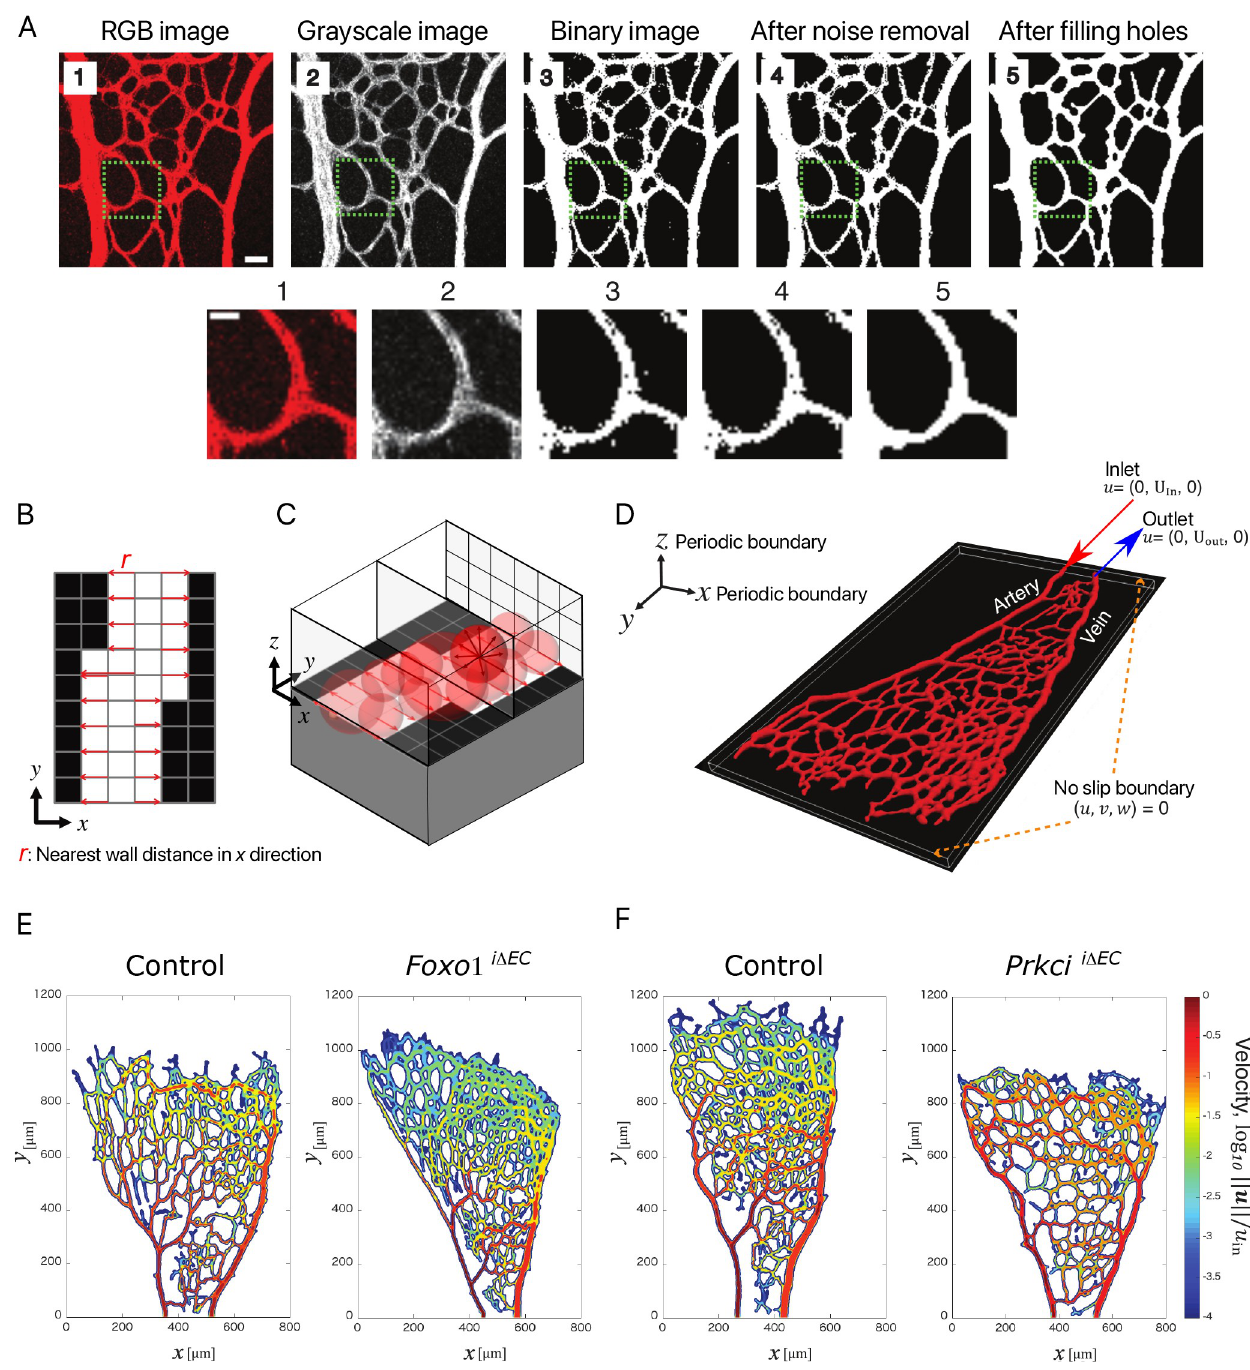
Fig 2. Image processing and blood flow simulation from the growing mouse retinal vasculature. A) Generation of binary vessel mask from RGB images. Higher magnification images of indicated areas in the upper panels are shown in the lower panels. Scale bar in the upper panel, 30 μ m; 10 μ m in the lower panel. B) Schematic of the searching process for the nearest solid wall (black pixel) on each pixel point and defining the local radius r (pixel distribution is projected on Cartesian grid coordinate ^ x = [ x , y ]). C) The local radius r for creating 3D vascular structure in a 3D Cartesian coordinate system, x = [ x , y , z ], extended from ^ x . The region with k x k < r is defined as blood vessel, while the rest is a surrounding tissue. D) Sample reconstructed 3D model of the retinal vasculature with indication of the inlet and outlet in Cartesian coordinate system. E) Visualization of the velocity amplitude on the central x-y plane (along the z axis) for Foxo1 i Δ EC and F) Prkci i Δ EC mutants and respective controls; Color scale represents the logarithmic form of the normalized velocity (log 10 k u k / u in ).